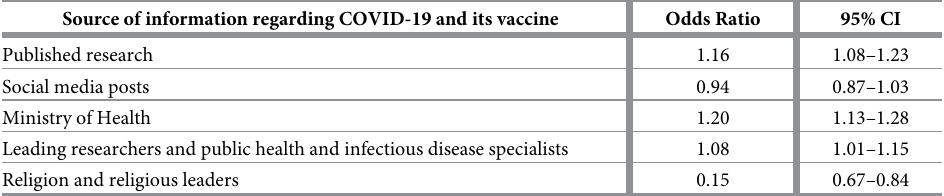
Table 6. Relationship between our participants’ source of information regarding COVID-19 and their acceptance of its vaccine. Source of information regarding COVID-19 and its vaccine Odds Ratio 95% CI